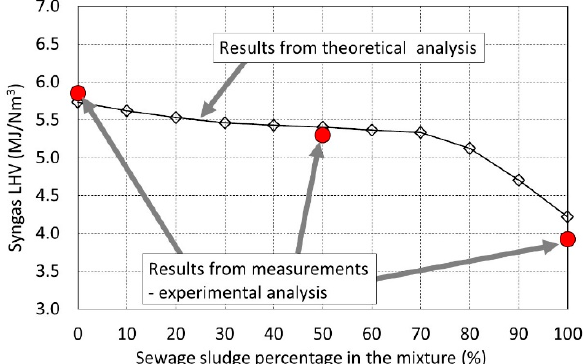
Figure 8. LHV of syngas vs. percentage of sewage sludge.